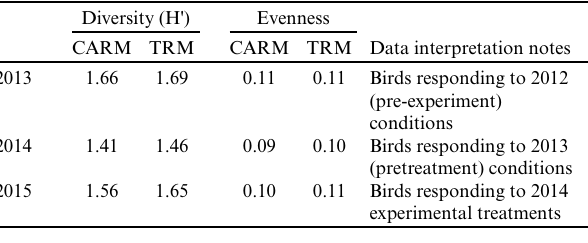
Table 2 . Bird diversity and evenness in collaborative adaptive rangeland management (CARM) and traditionally managed treatment (TRM) in the baseline year (2013) and two initial treatment years (2014 and 2015). These data were interpreted by the stakeholders to be inconclusive.